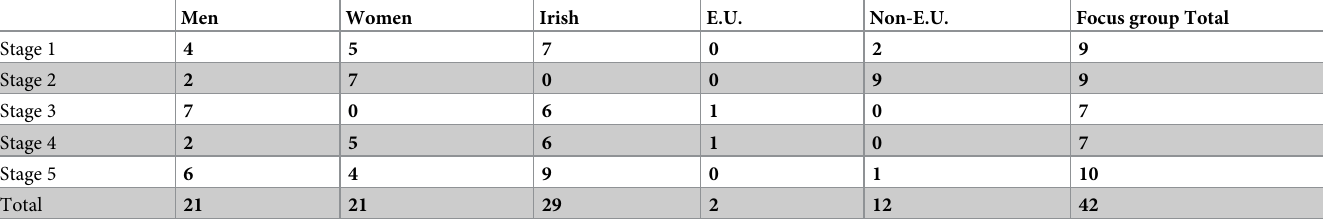
Table showing demographics of the focus group participants. Students identified as Males or Females, and either Irish, E.U., in both cases French, or Non- E.U. from Malaysia, Canada, USA, Singapore, Nigeria, Botswana and Australia. Focus group number ranged from 7–10 per group and 42 students were included in total.